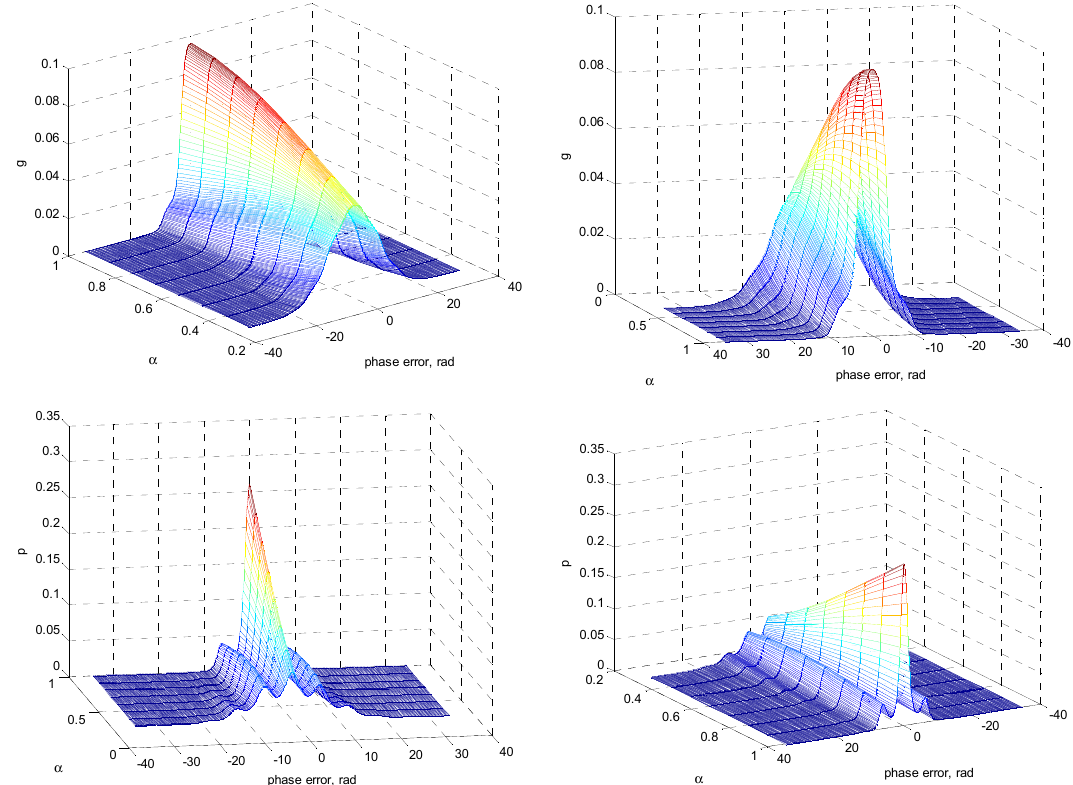
Figure 10. Three-dimensional plots for nonmodulo-2 π g and p , respectively, at τ = 10 for various SNR values: front view ( left ) and back view ( right ; γ = 0 ).